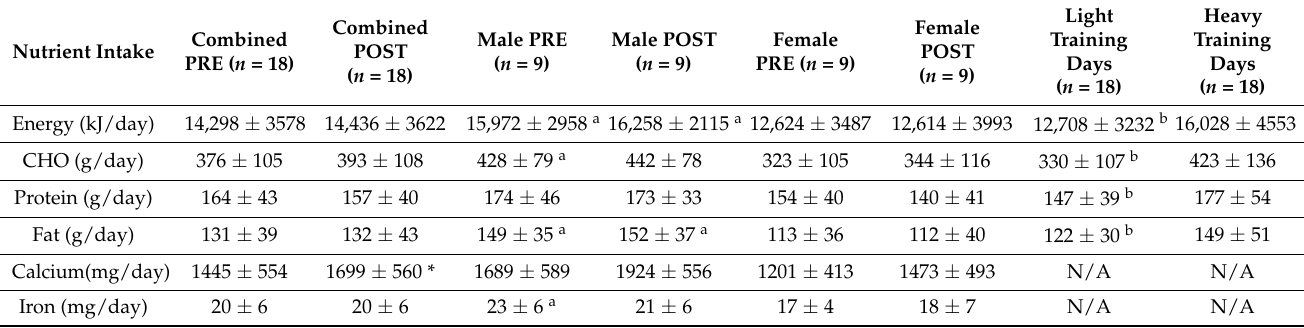
Table 3. Daily nutrient intakes of junior elite triathletes (mean ± SD) before and after the 8-week nutrition education program ( n =